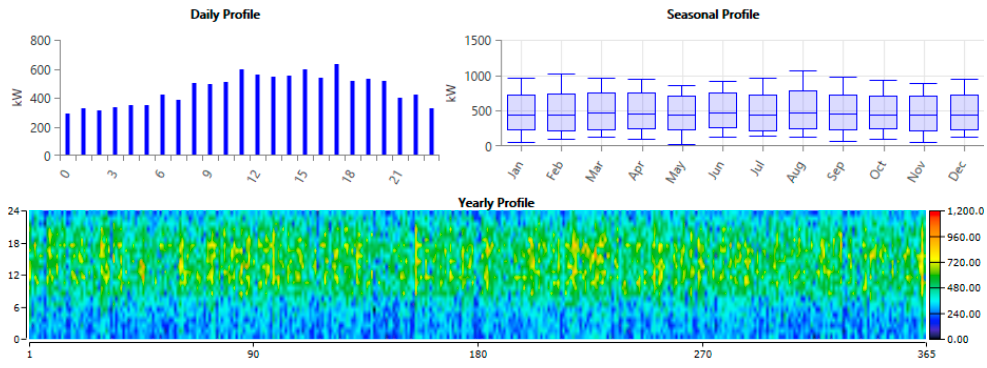
Figure 2. Electrical load in a CHP plant integrated microgrid.